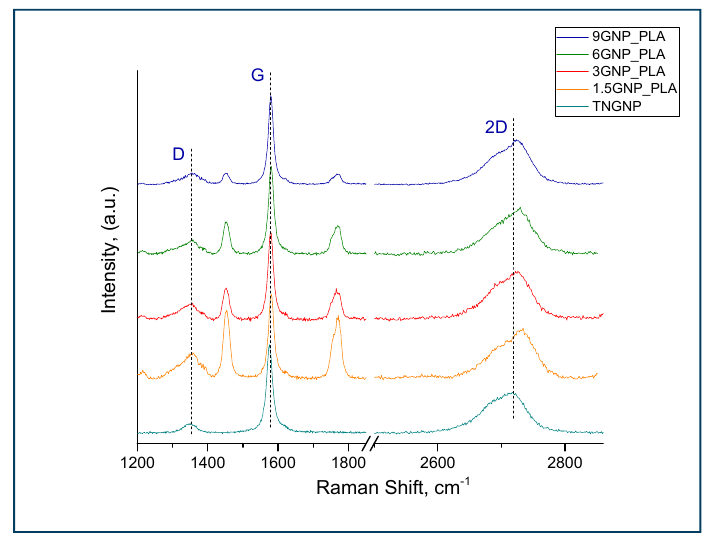
Figure 4. Normalized Raman spectra of nanocomposites with growing GNPs concentration and pristine graphene as reference.